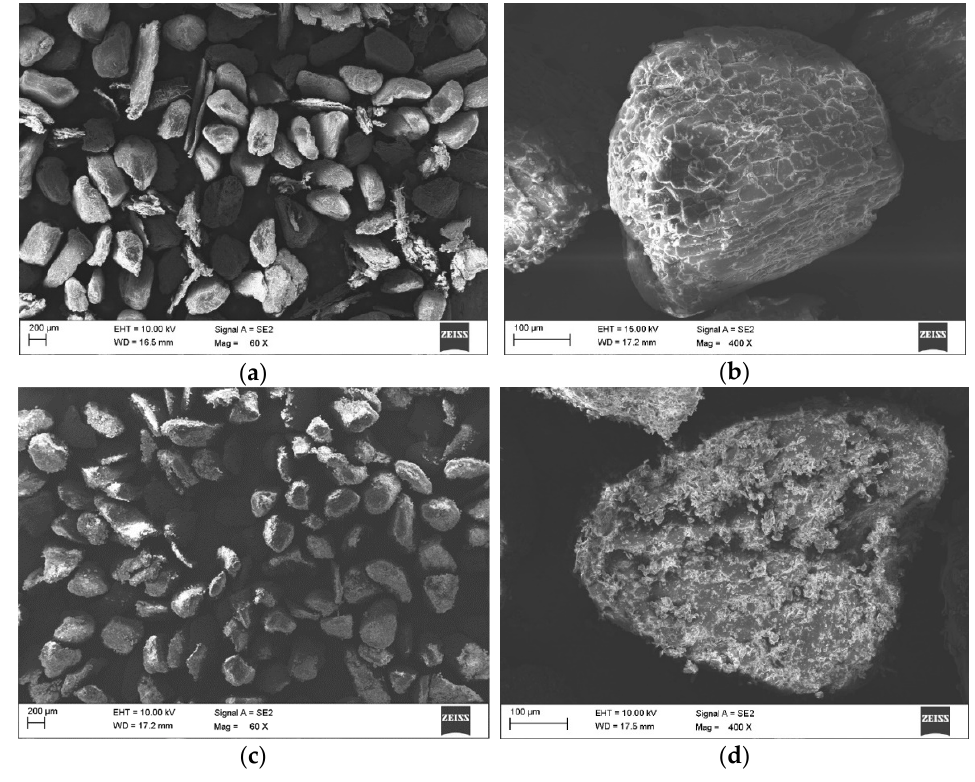
Figure 1. Photos of hazelnut shell meal ( a , b ) and walnut ( c , d ).